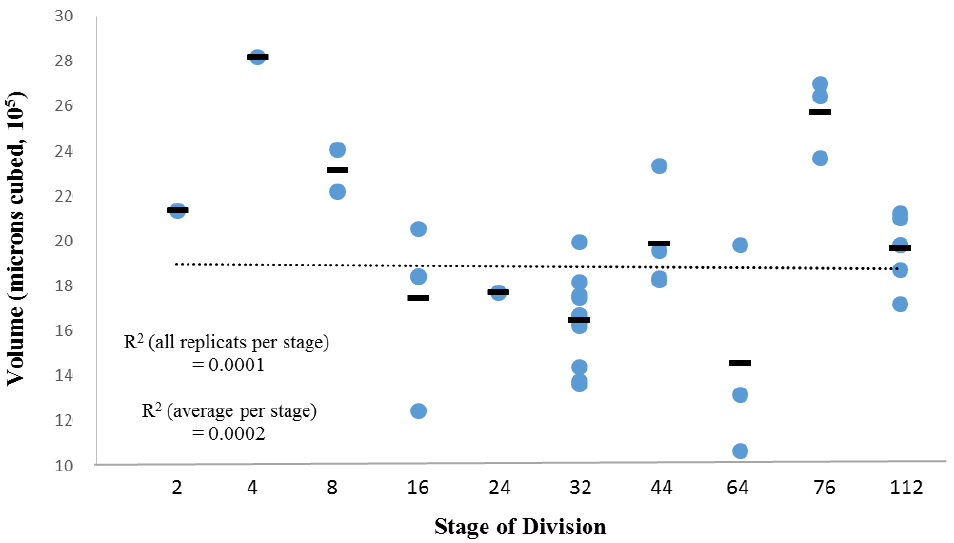
Figure 2. Embryo volume per cell stage of embryogenesis for Ciona . Volume (measured in cubic microns) is averaged over a number of observations (N). N (stage) is given in Table S1.